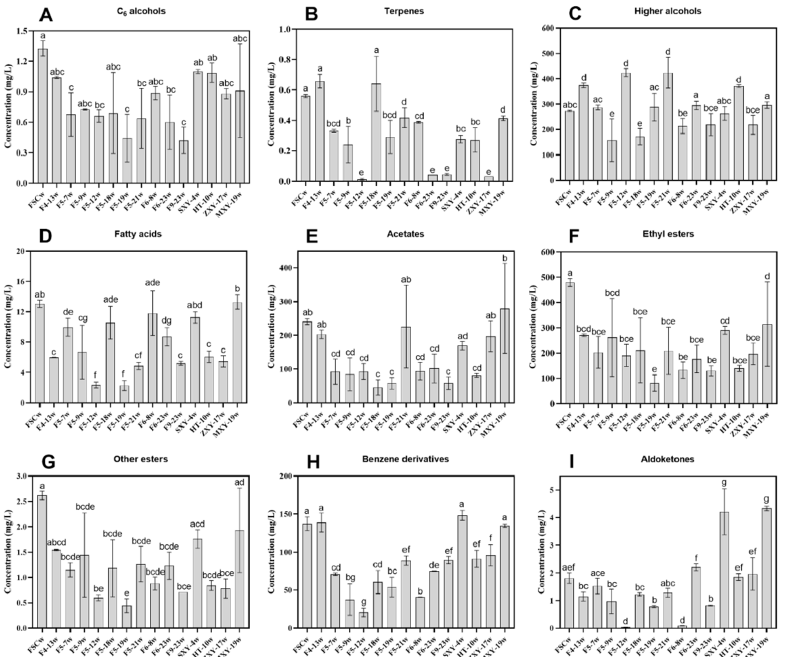
Figure 5. Categories and contents of the aroma compounds in wines fermented by the selected S. cerevisiae strains (( A ): C 6 compounds; ( B ): terpenes; ( C ): higher alcohols; ( D ): fatty acids; ( E ): acetates; ( F ): ethyl esters; ( G ): other esters; ( H ): benzene derivatives; ( I ): aldoketones). Different lowercase letters indicate significant differences ( p < 0.05).